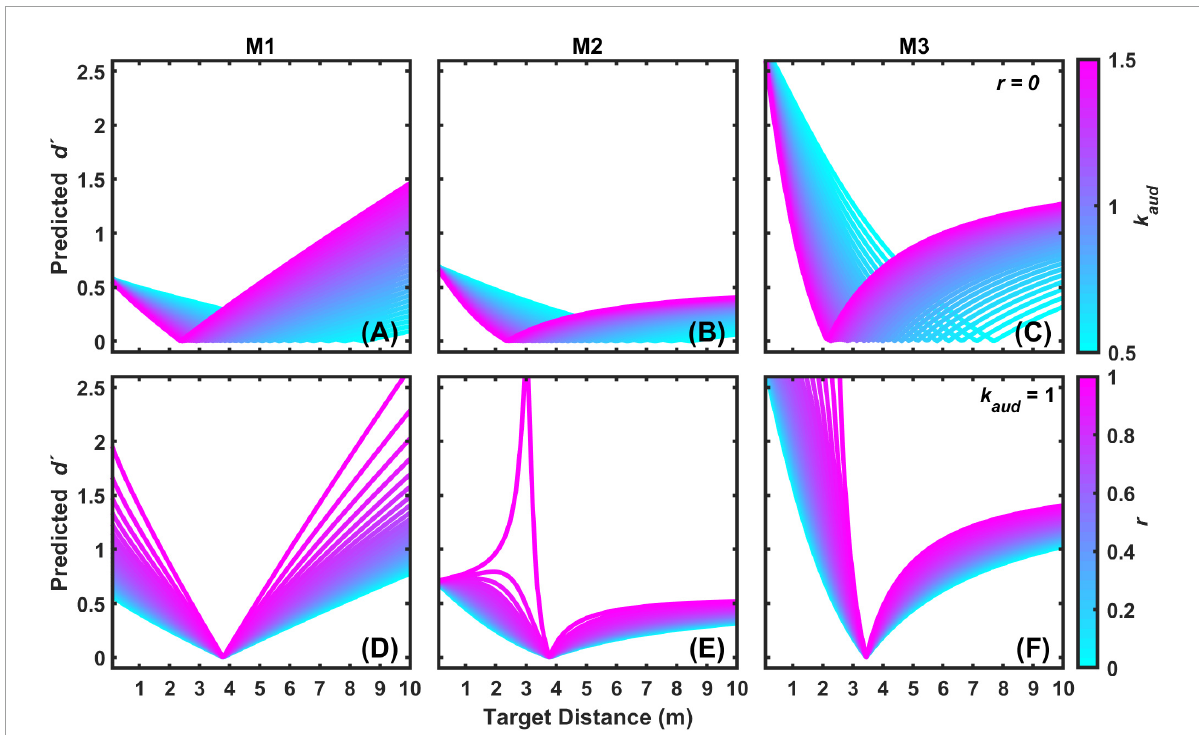
FIGURE7 Examples of predicted d (cid:48) functions for the 3 m visual target distance for each 2-parameter model (M1–M3) as a function of k aud with r = 0 (A–C) , and as a function of r with k aud = 1 (D–F) .